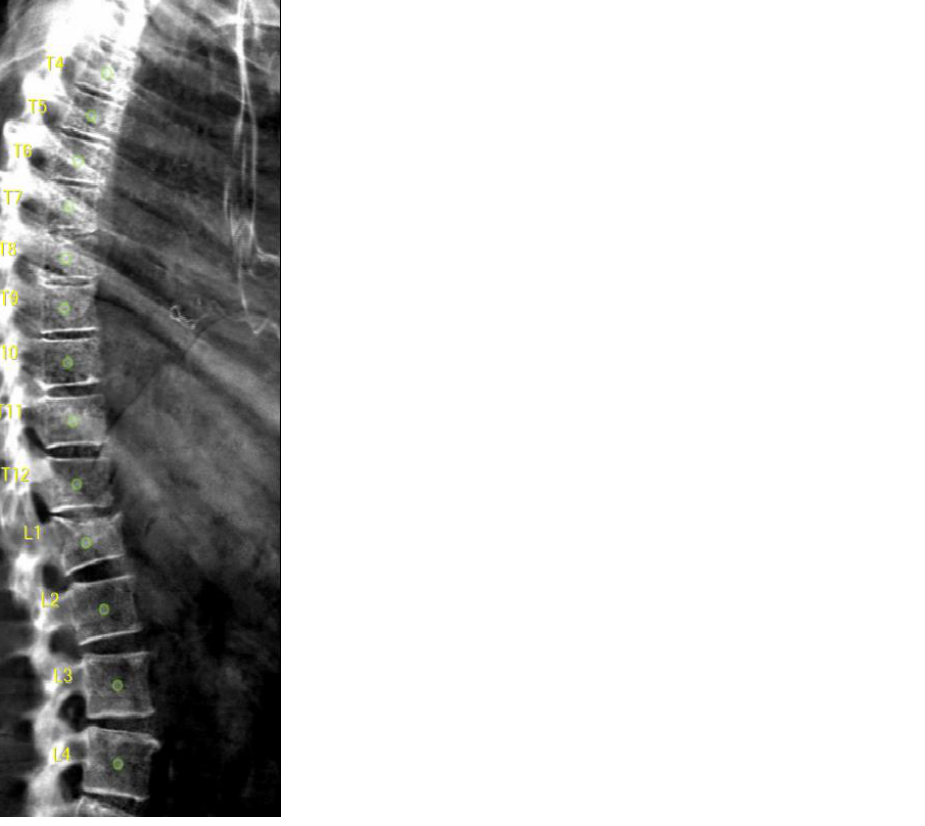
Figure 4. An example DXA VFA image that had an expert disagreement in the identification of T12 and/or L1.